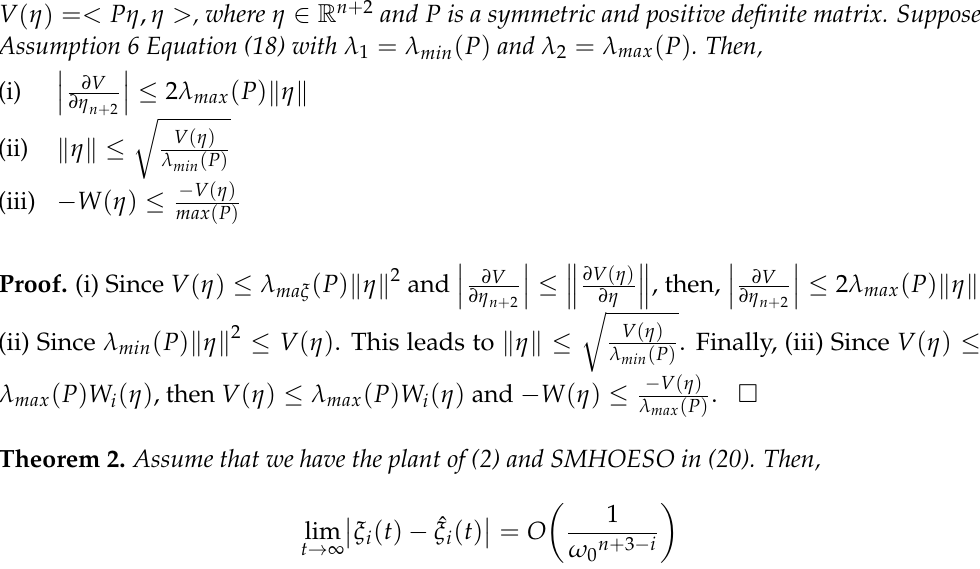
with ℊ 𝛽𝛽 = 0.334, 𝛼𝛼 = 0.533, 𝑘𝑘 𝛽𝛽 = 0.543, 𝑘𝑘 𝛼𝛼 = 0.617